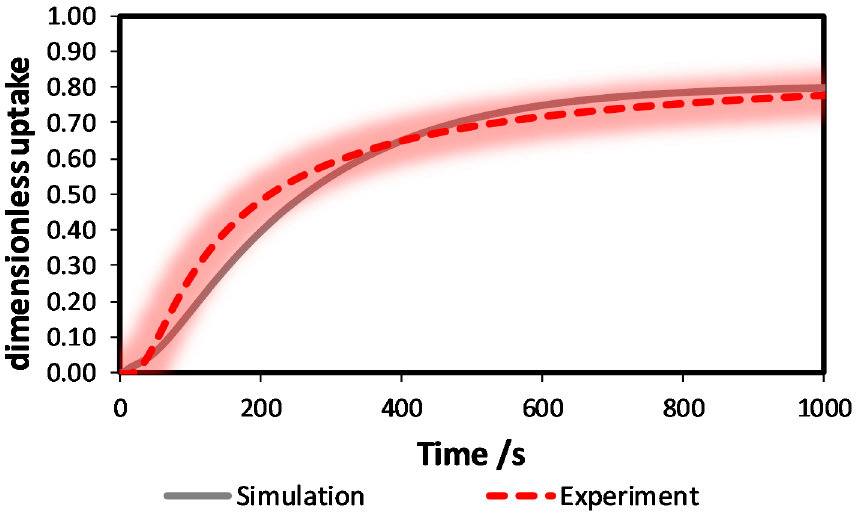
Figure 7. Validation of the model for the adsorber. The red area represents experimental error.